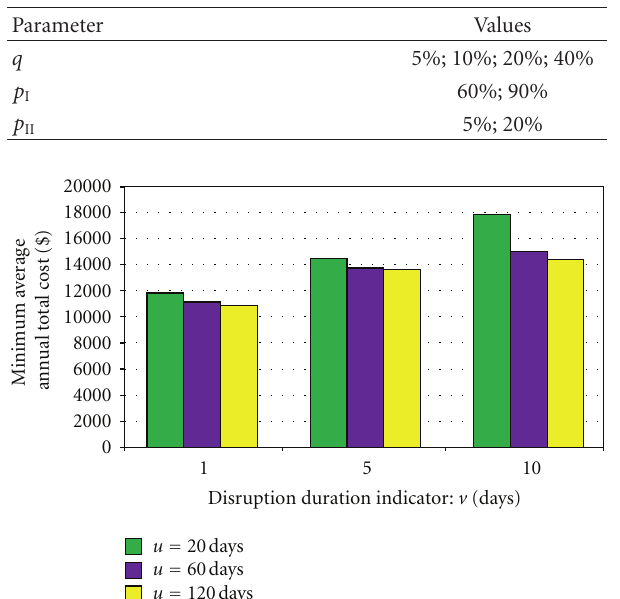
Table 3: The design for the second experiment.